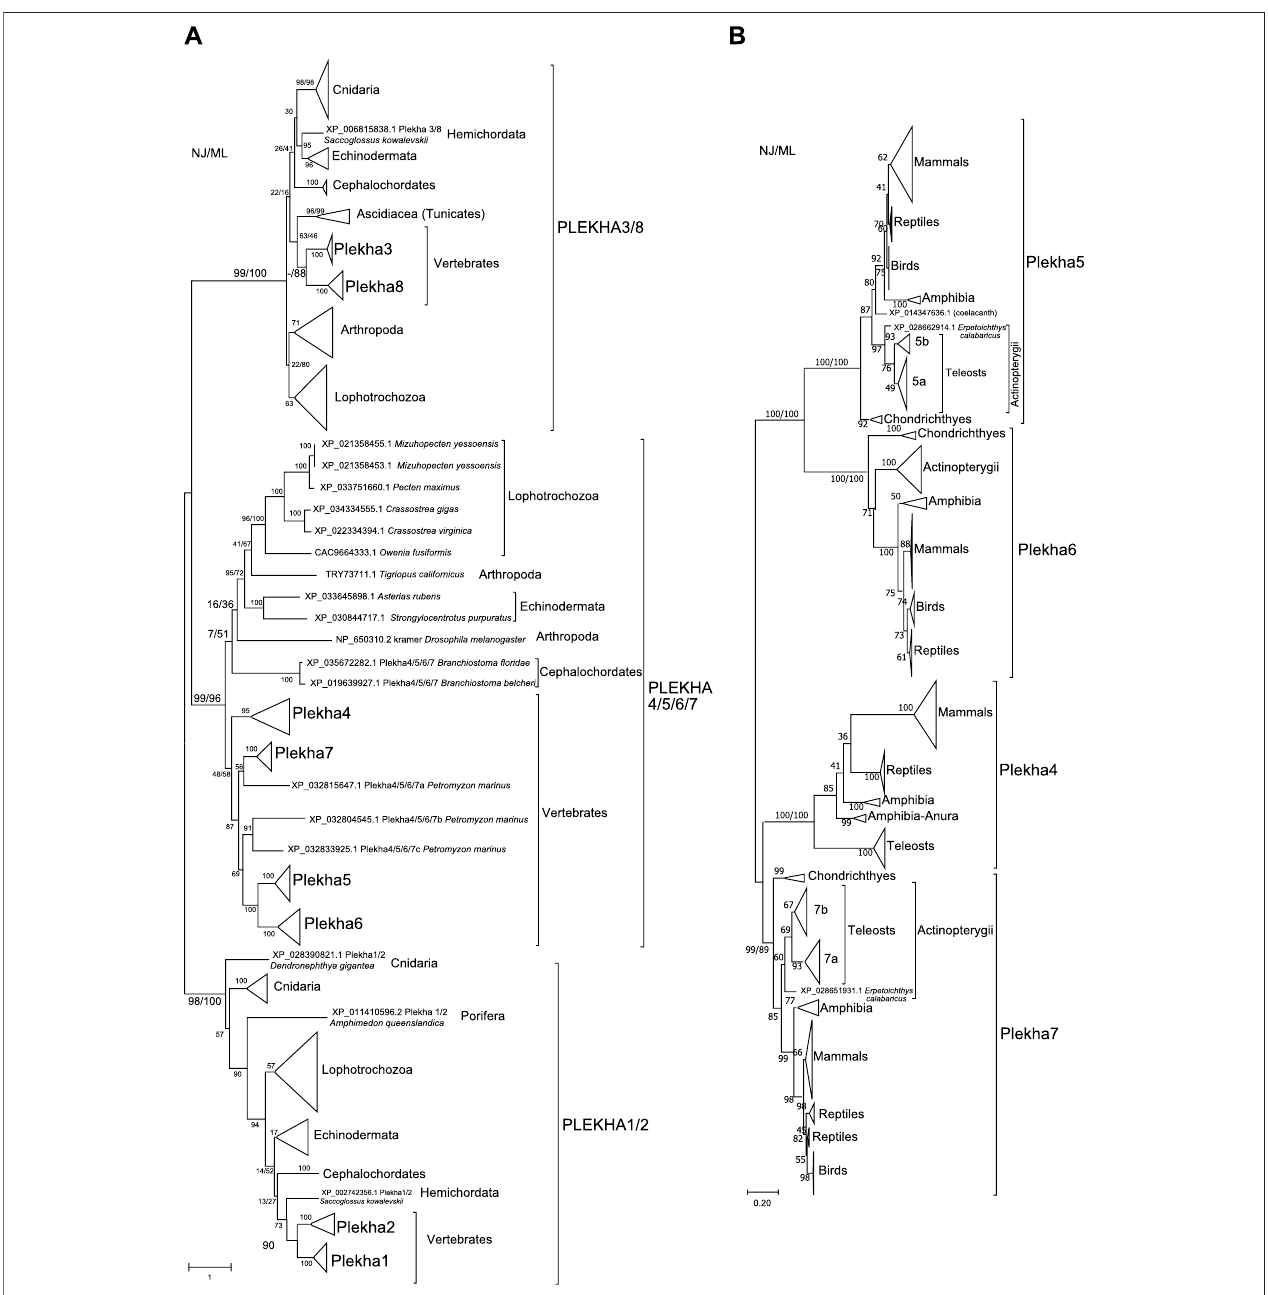
FIGURE2| PhylogeneticanalysesofthePLEKHAproteinfamilyrevealtheexistenceofdistinctsubfamiliesandparalogousgroups. (A) Evolutionaryrelationshipsof all the members of the PLEKHA protein family, as inferred by the Neighbor-Joining and the Maximum Likelihood methods using JTT matrix-based model. The optimal tree and the tree with the highest log likelihood (-123550.77) are shown. A discrete Gamma distribution was used to model evolutionary rate differences among sites [5categories(+ G ,parameter=2.0629)].Thetreeisdrawntoscale,withbranchlengthsmeasuredinthenumberofsubstitutionspersite.Thisanalysisinvolved107 amino acid sequences. All positions containing gaps and missing data were eliminated (complete deletion option) and a total of 77 positions were used (see Supplementary Figure S1 for uncompressed tree). (B) Evolutionary relationships of the vertebrate Plekha4,5,6,7 proteins, as inferred using the Neighbor-Joining and the Maximum Likelihood methods based on the JTT matrix-based model, with complete deletion of amino acid positions containing gaps. There was a total of 245 positions in the fi nal dataset. The optimal tree and the tree with the highest log likelihood (-16497.96) are shown. A discrete Gamma distribution was used to model evolutionary rate differences among sites [5 categories (+ G , parameter = 1.5563)]. The tree is drawn to scale, with branch lengths measured in the number of substitutions per site. This analysis involved 231 amino acid sequences. The major clades are compressed for better visualization (see Supplementary Figure S2 for uncompressed tree). In both fi gures, bootstrap values (numbers at nodes for NJ and ML) indicate the percentage of 1,000 replicates in which the associated taxa clusteredintheresultingtree(valuesfrombothtreesareshownonlyformajorclades).Adashinsteadofabootstrapvalueindicatesthatthebranchwasnotsupportedby a speci fi c method. Teleost-speci fi c copies are indicated by 5a,b and 7a,b; lamprey-speci fi c copies are indicated by 4/5/6/7a,b,c.